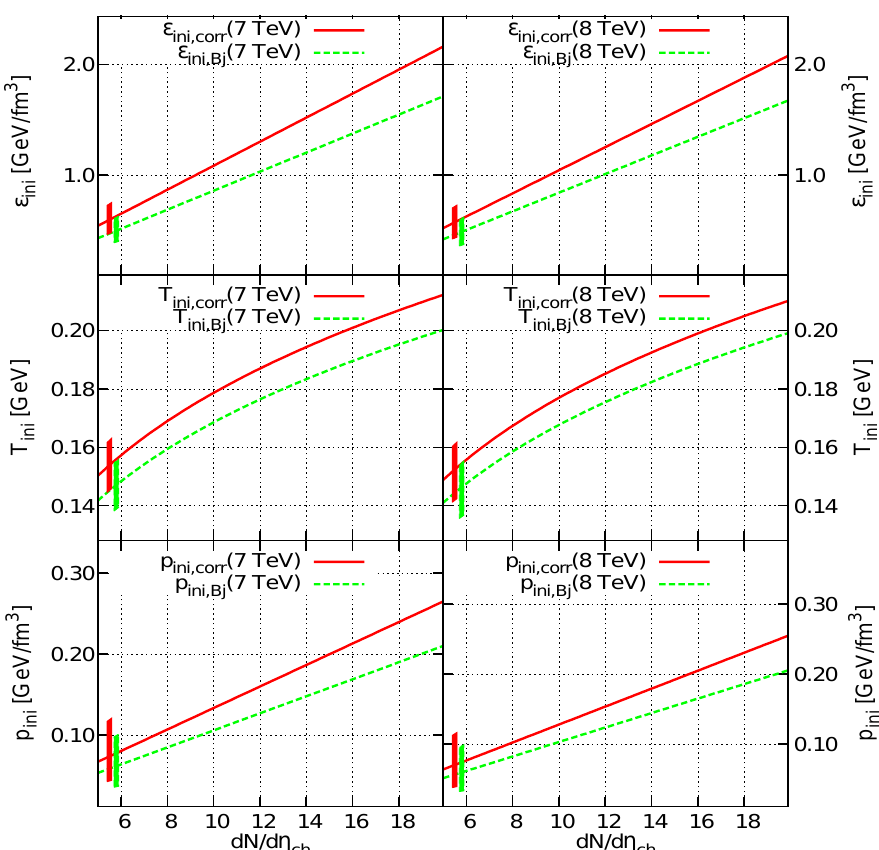
Figure 3. Initial energy density (based on Table 1), temperature and pressure (based on the (cid:101) ∝ T 4 relationship) at 7 TeV (left) and 8 TeV (right), is indicated as a function of central charged particle multiplicity density. The Bjorken-estimate (dashed curve) is above the critical energy density of 1 GeV/fm 3 if the multiplicity is larger than 12. Corrected initial energy density (solid curve) is above the critical value if multiplicity is larger than 9. Boxes (parallelograms) show systematic uncertainty (estimated from the 7 TeV